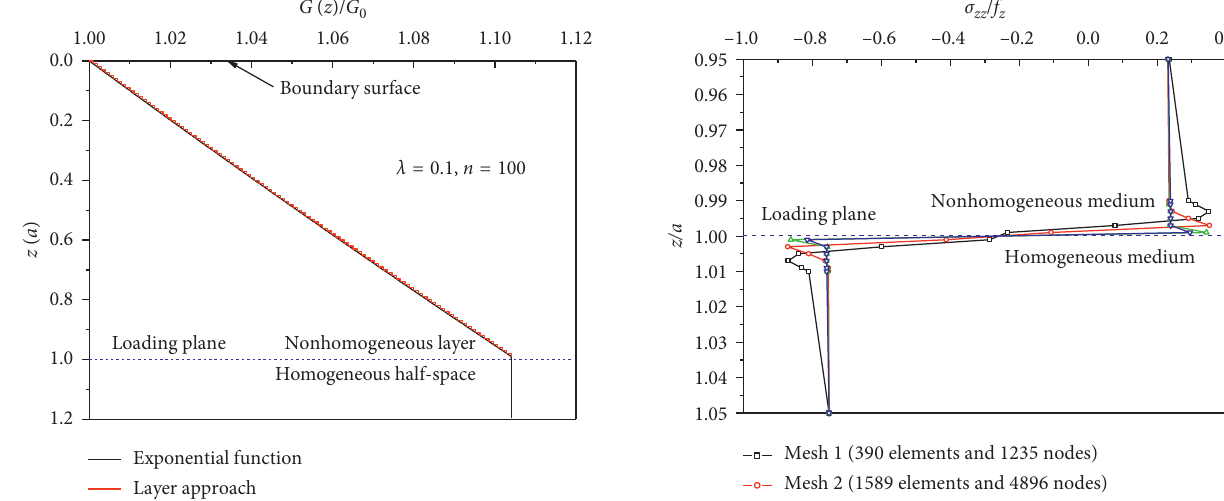
z (0, 0, z ) for different